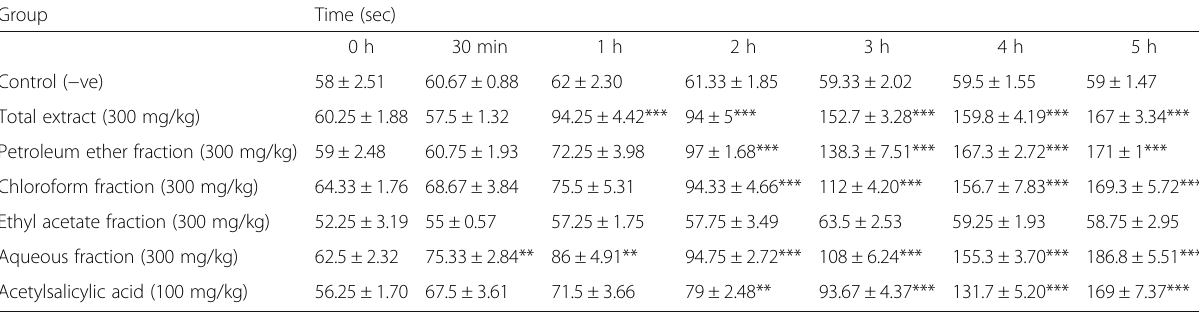
Table 3 Results of the analgesic activity of the total ethanolic extract and different fractions of A. hirtum leaves in mice using the hot plate method